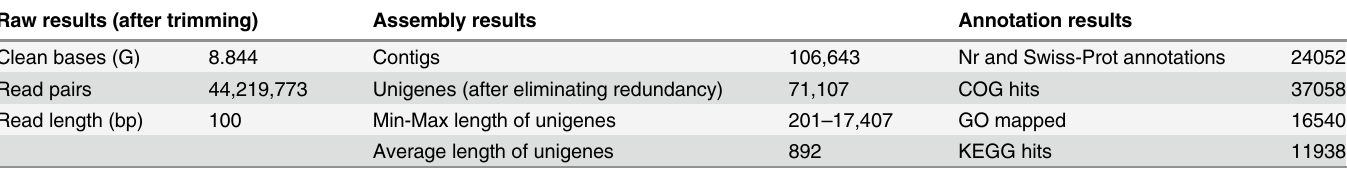
Table 1. Summary of Illumina transcriptome, assembly and annotation for Scophthalmus maximus . Raw results (after